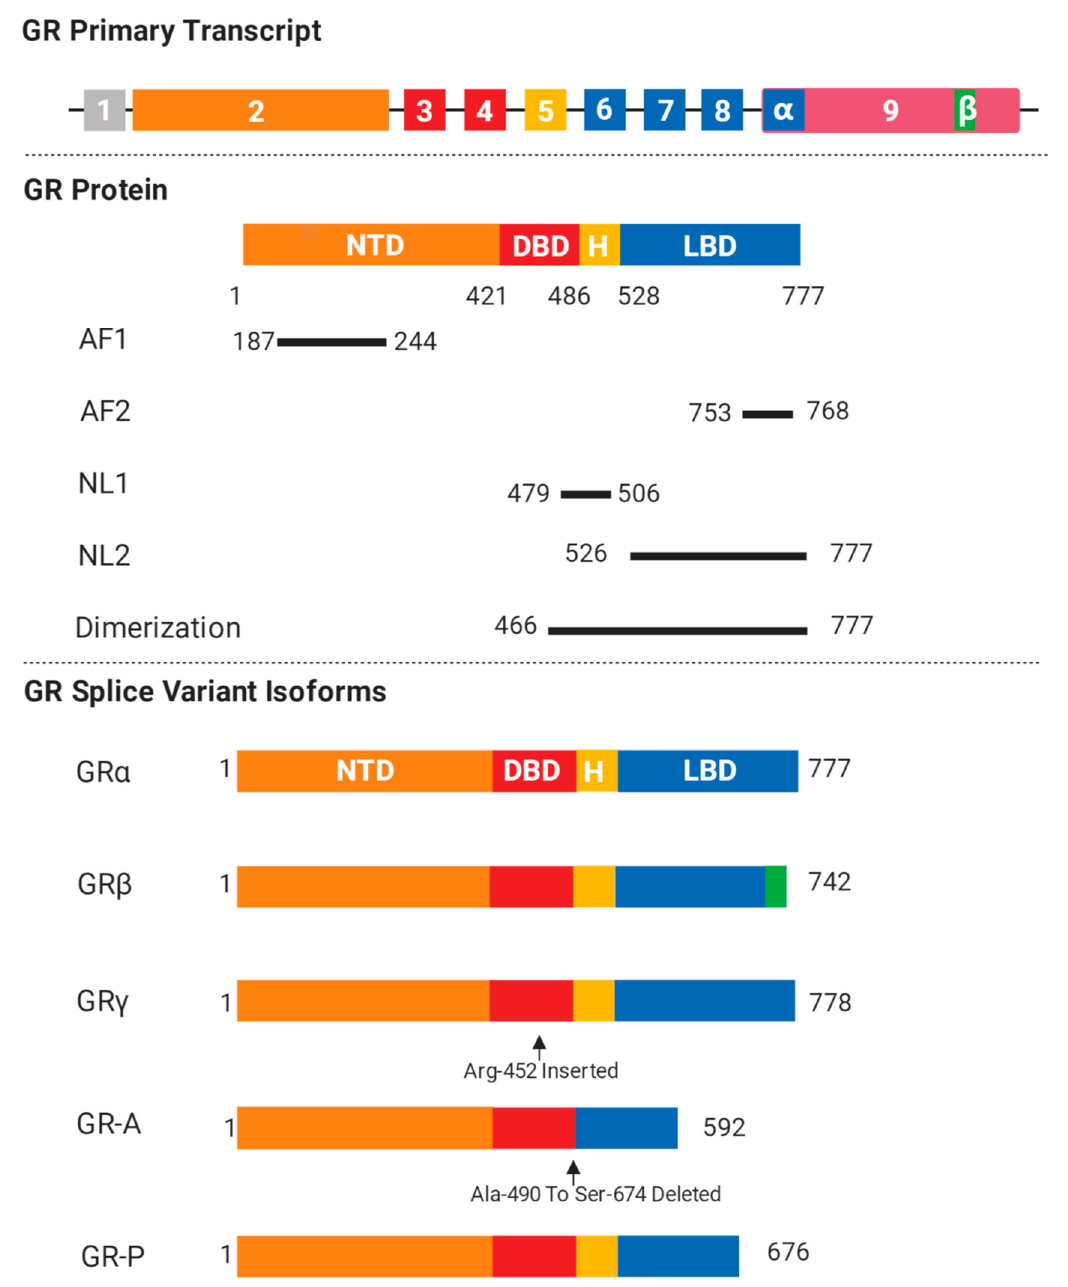
Figure 1. Glucocorticoid receptor (GR) isoforms and structure.